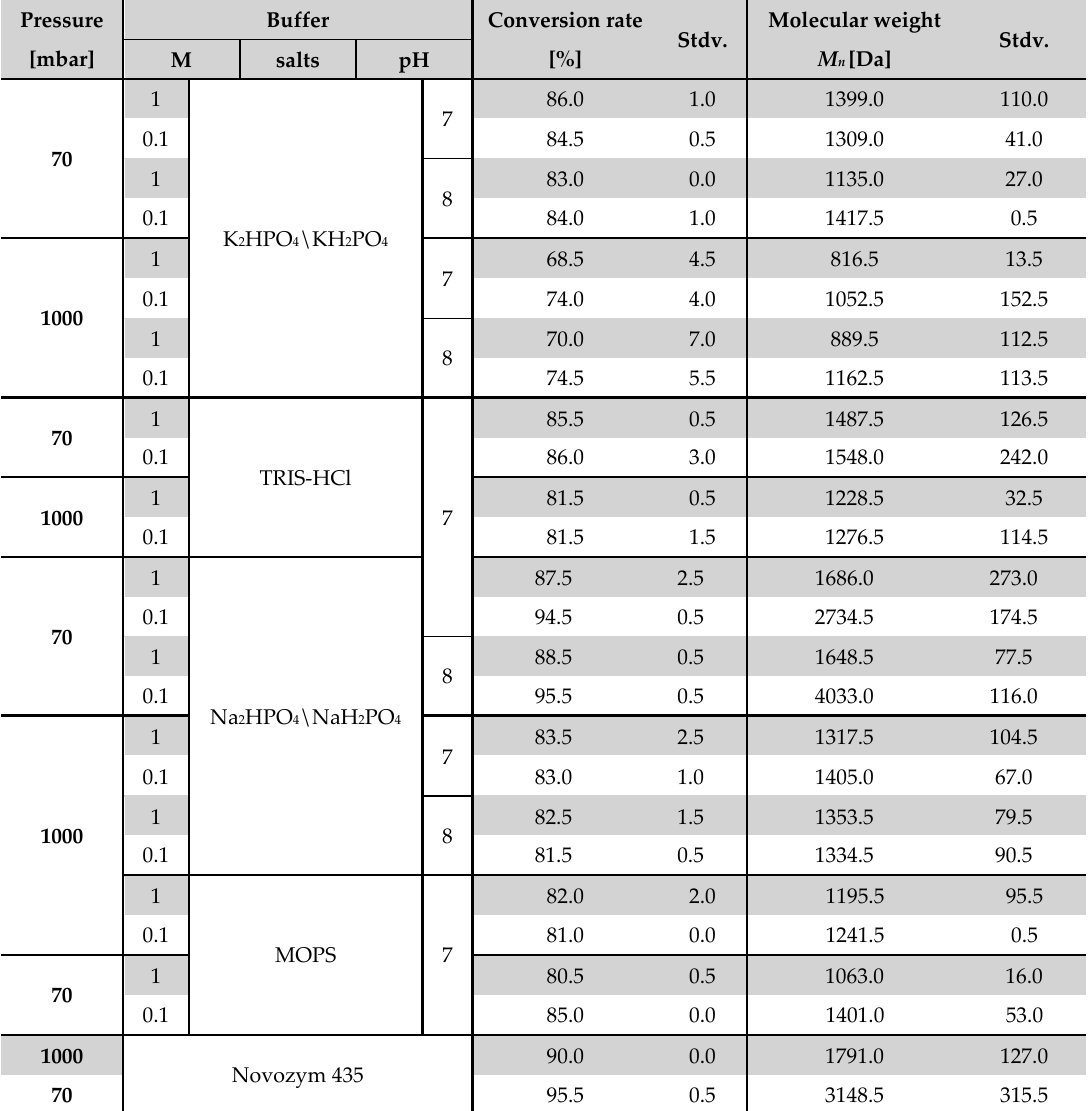
Table 1. Conversion rate [%] and molecular weight M n [Da] of polyesters synthetized with CaLB